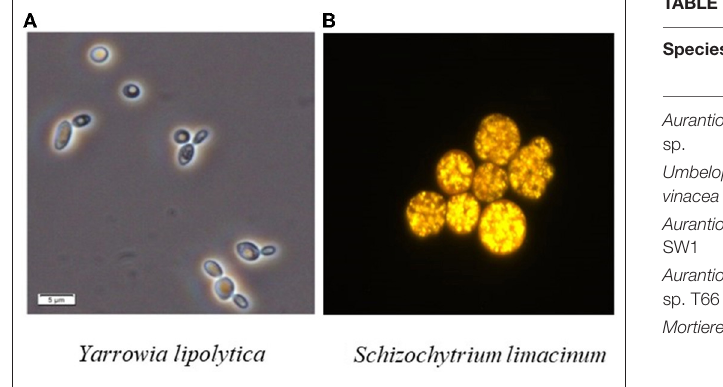
FIGURE 1 | Lipid bodies from different oleaginous fungi. (A) Wang et al. (4); (B) Fillet et al.